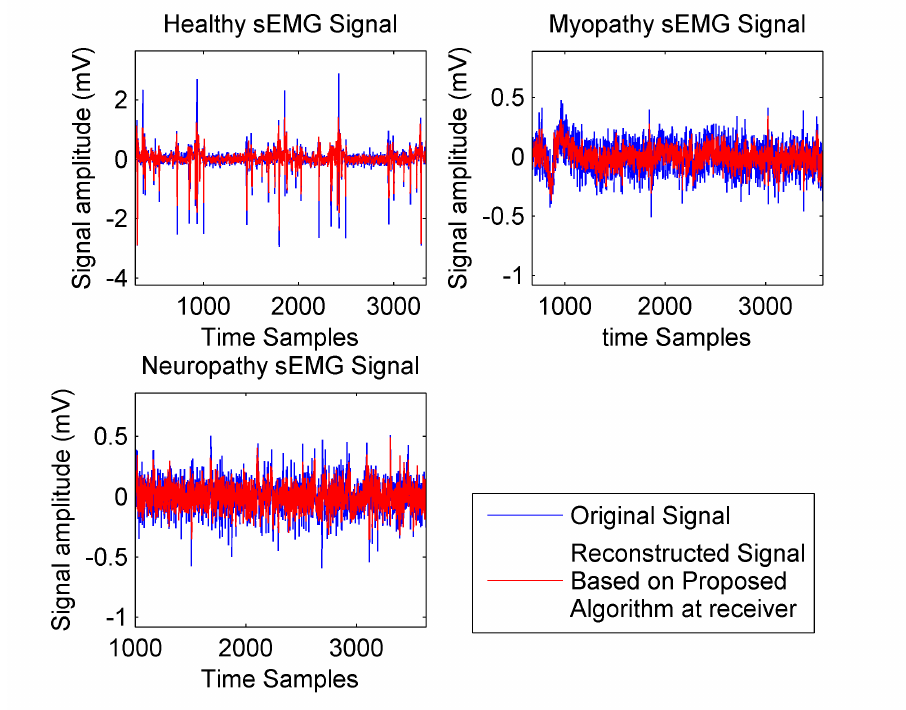
Figure 6. Performance of reconstruction process.